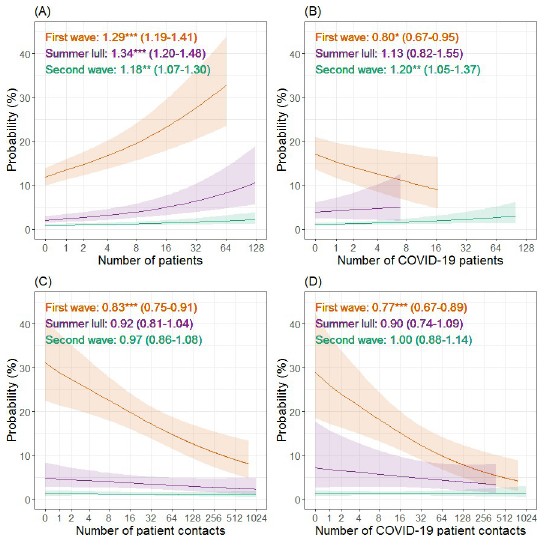
Fig 3. The relationship between patient contact and the probability of healthcare workers testing positive for COVID-19 during the first year of the COVID-19 pandemic. Estimates (and 95% confidence intervals) from a mixed effects logistic regression are plotted for the first wave (orange), summer lull (purple) and second wave (green). Plots A & C show the effect of the total number of patients and total number of patient contact events on the probability of a positive test result. Plots B & D show the same effects, but metrics are derived from contact events with only patients identified as COVID-19 positive and is relative to the total number of patients/contacts. Odds ratios, statistical significance (as indicated by asterisks; * p < 0.05; ** p < 0.01; *** p < 0.001) and 95% confidence intervals are also reported. For all plots the x-axis is on a logged scale (base